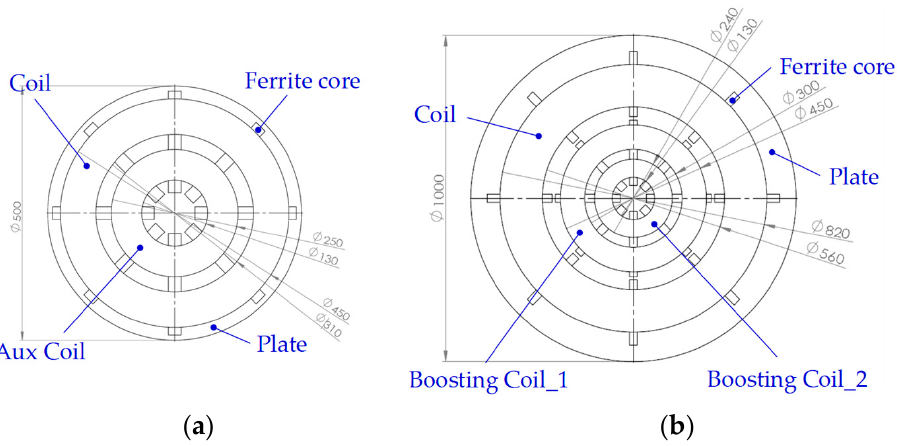
Figure 13. Receiver coil on the secondary side. ( a ) Rx coil; ( b ) Tx coil.